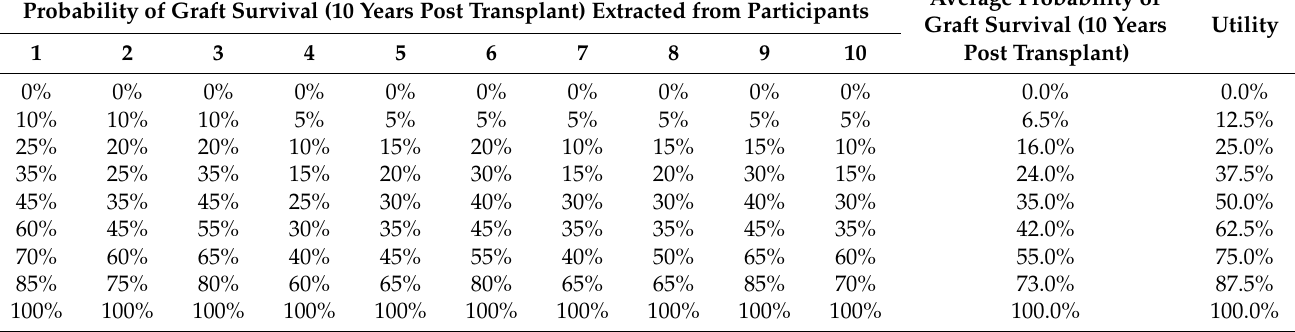
Table A1. Reference Data for Utility Function. Probability of Graft Survival (10 Years Post Transplant) Extracted from